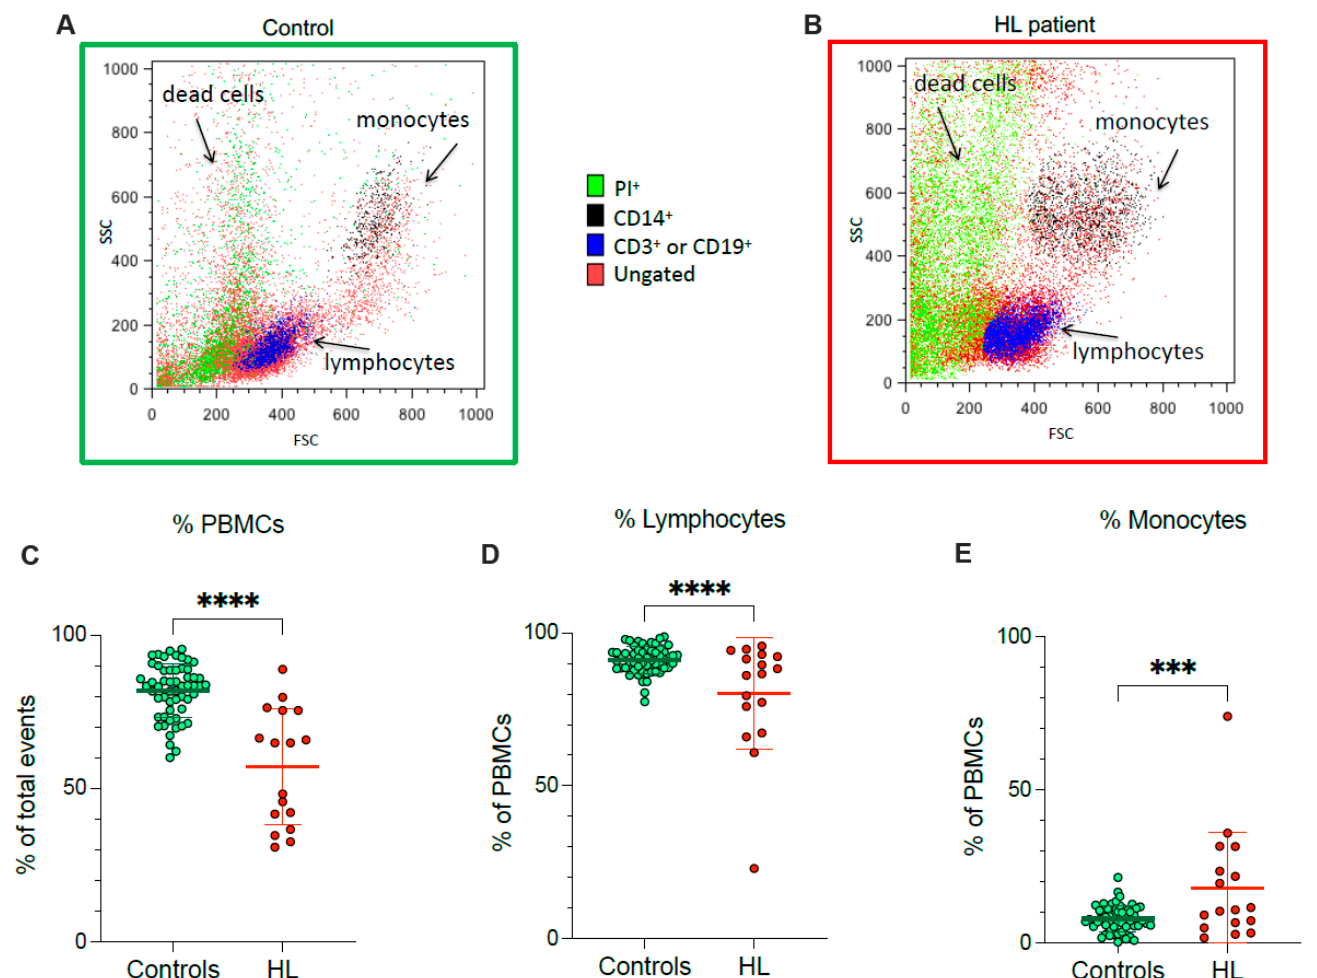
Figure 1. PBMC cell culture. Representative flow cytometry dot plots of forward- and side-scatter features (FSC, x-axis, and SSC, y-axis) of PBMCs showing the recovery of lymphocytes and monocytes in the expected gates of controls ( A ) and HL patients ( B ). Percentage of PBMCs ( C ), lymphocytes ( D ) and monocytes ( E ) sampled from controls (green) and HL patients (red). Graphs display individual data and mean ± SD. *** = p < 0.002, **** = p < 0.001.